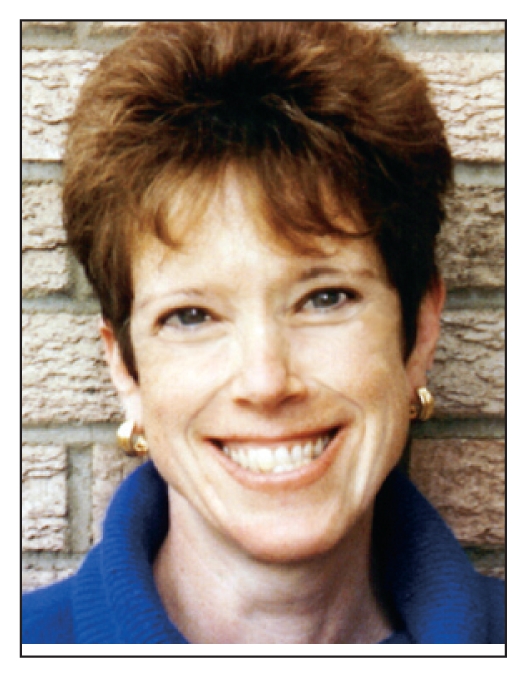
Judith Zelikoff